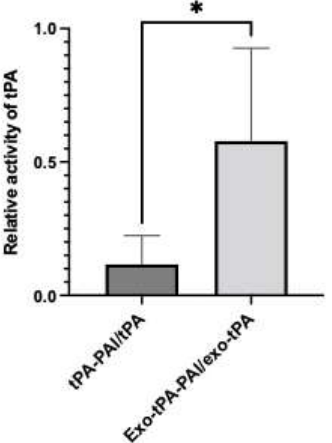
Figure 3. Activity of the tPA and exo-tPA with and without plasminogen inhibitor at equimolar amount. The tPA activity was assessed after 30 min treatment with plasminogen inhibitor at room temperature. n = 3 ± SEM, * p < 0.05.